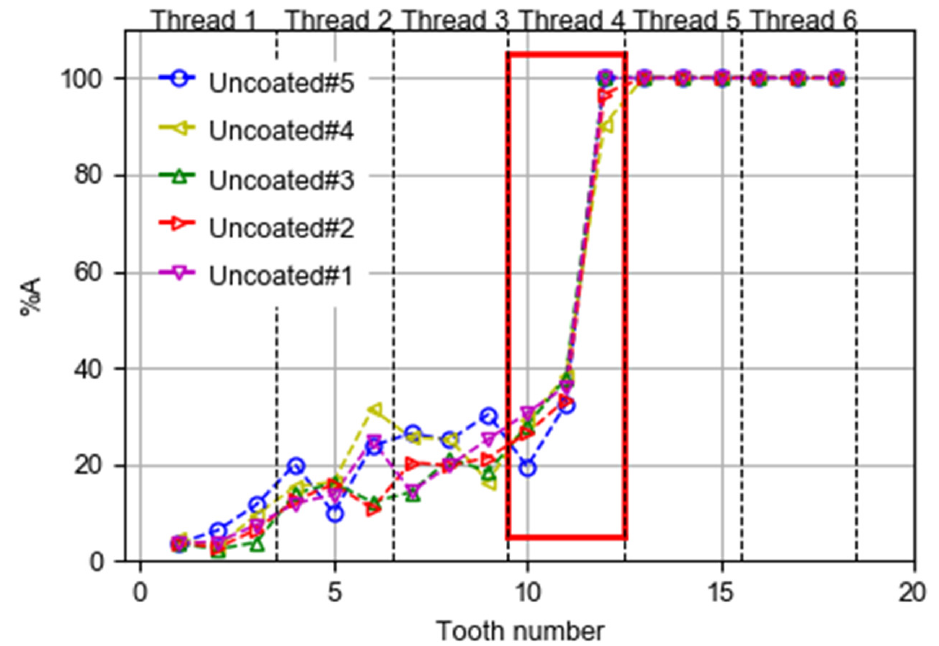
Figure 14. Evolution of %A parameter on the teeth of uncoated taps.